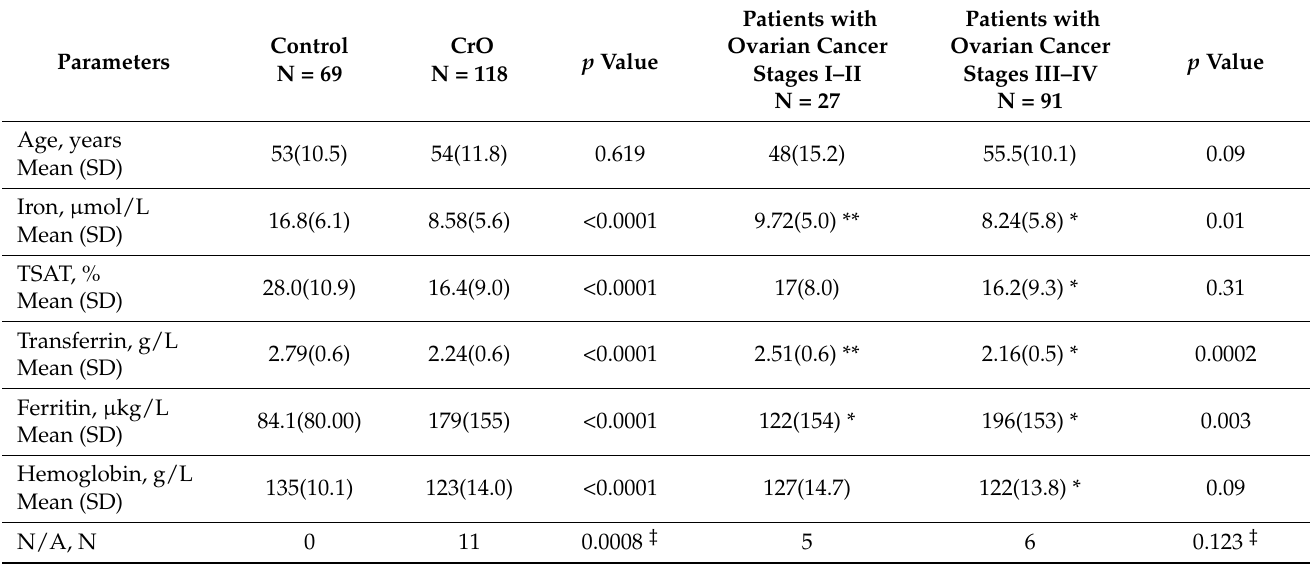
Table 1. Indicators of iron status in patients with ovarian cancer and those in the control group.